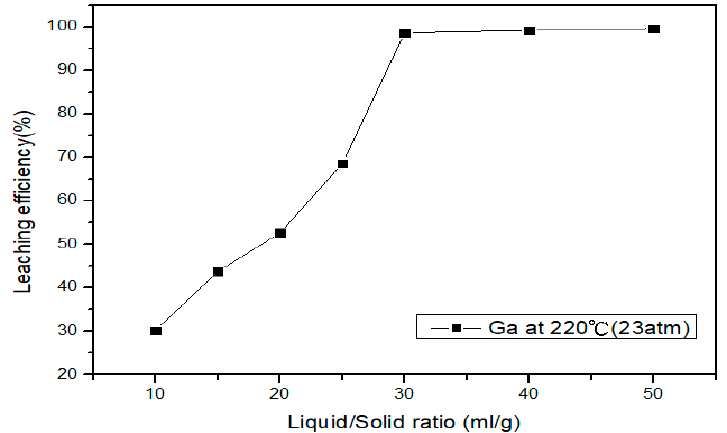
Figure 8. Effect of liquid/solid ratio on the leaching efficiency of gallium in 0.25 M HCl at 220 °C for 4 h.